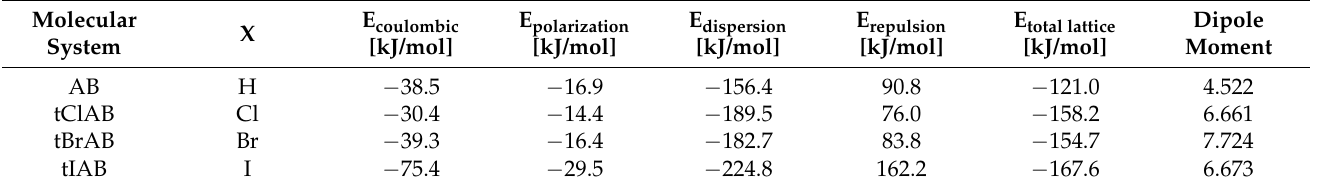
Table 3. Separation of coulombic/polarization/dispersion/repulsion terms to the total lattice calculated within Pixel.